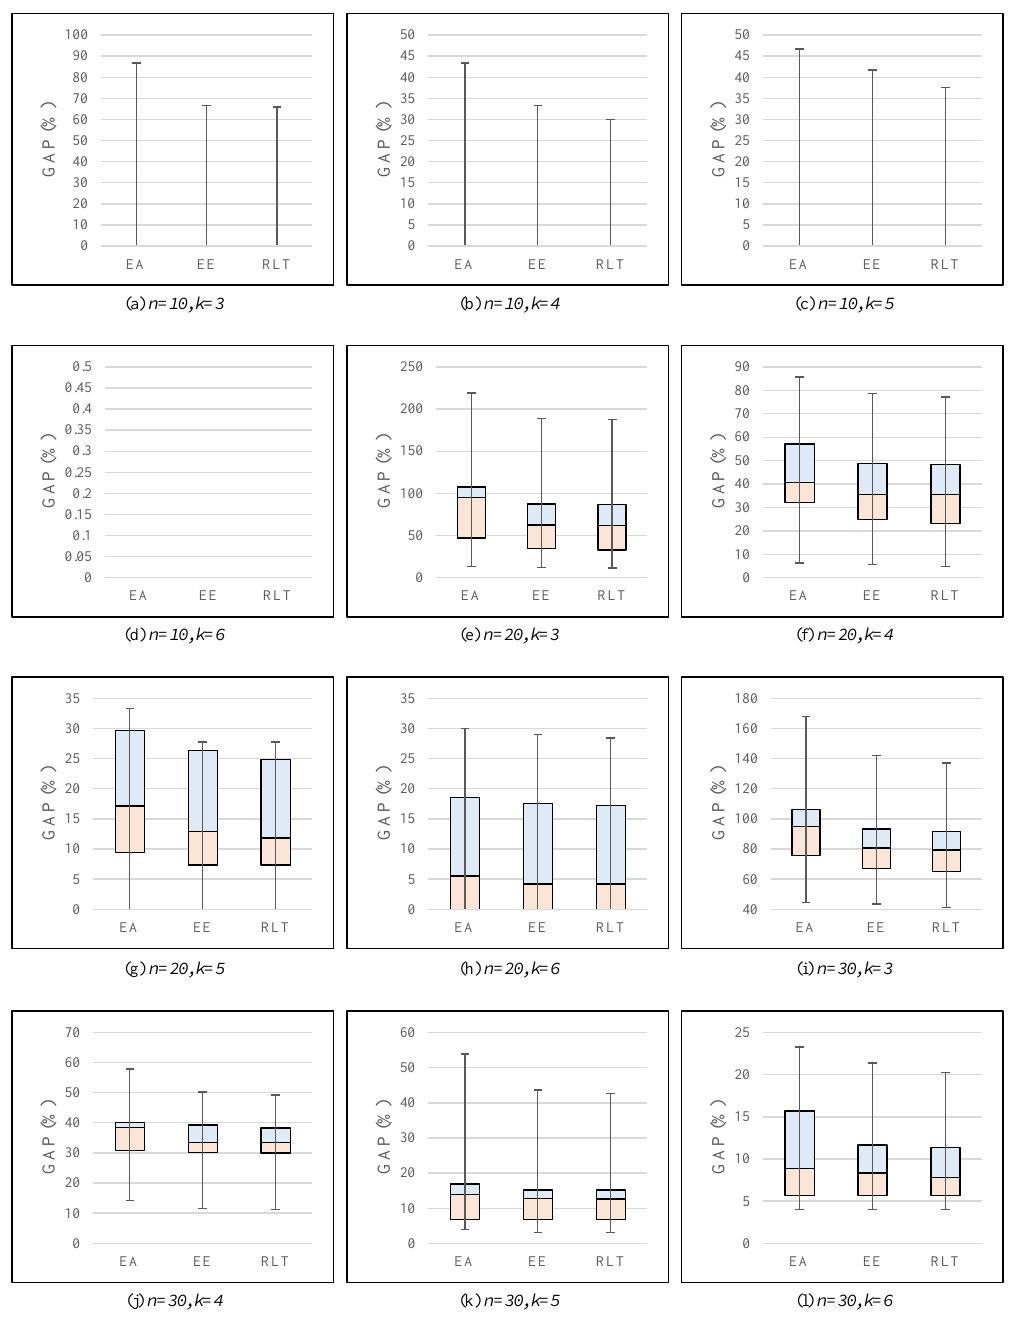
Figure 5. Box plots of optimality gaps (GAPs) for low-density